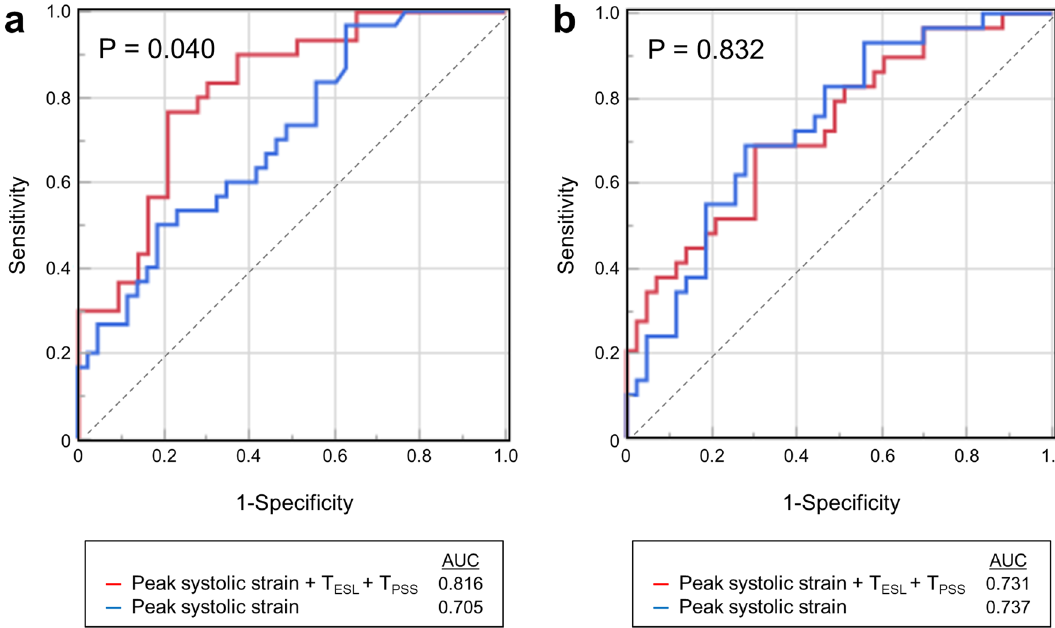
Figure 4. Receiver operating characteristic curve analysis for diagnosing left anterior descending artery (LAD) stenosis. ( a ) Compared with the peak systolic strain alone, the integrated analysis of the three parameters from using the regression function significantly improved the accuracy in diagnosing single-vessel LAD stenosis ( P = 0.040). ( b ) The integrated analysis did not improve the accuracy in diagnosing multivessel LAD stenosis ( P = 0.832). Before revascularization After